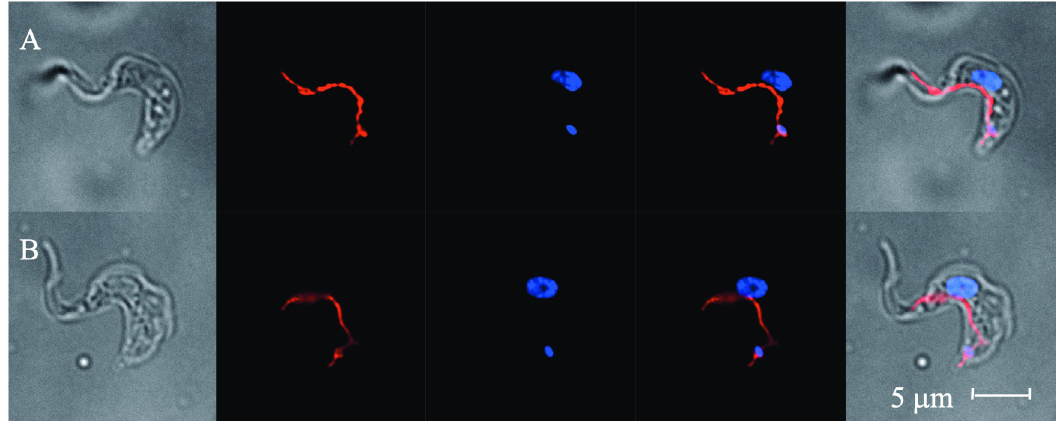
Fig 3. Representative images of T . brucei BSF. A. Control cells. B. Cells treated with analogue 10 (EC 10 ). From left to right: DIC microscopy identifying cellular structure; MitoTracker Red fluorescence identifying parasite mitochondria; DAPI fluorescence identifying parasite DNA (nucleus and kinetoplast); DAPI and MitoTracker Red fluorescence overlay; DIC, DAPI and MitoTracker Red